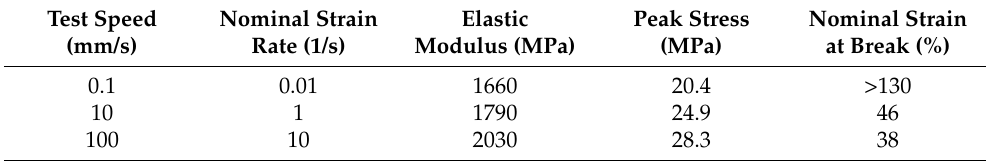
Table 1. Basic properties of the compact grade used for this work measured at different strain rates.